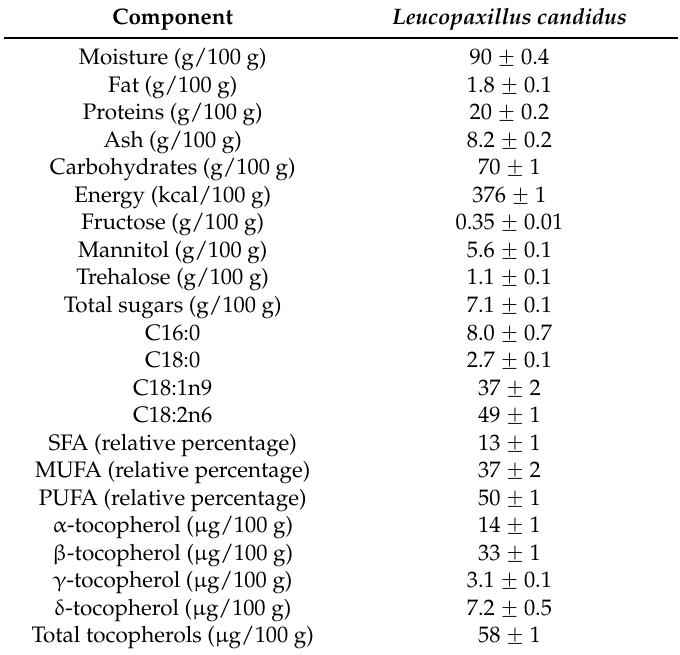
Table 1. Macronutrients, free sugars, fatty acids and tocopherols of the fruiting bodies expressed in dry weight basis (mean ˘